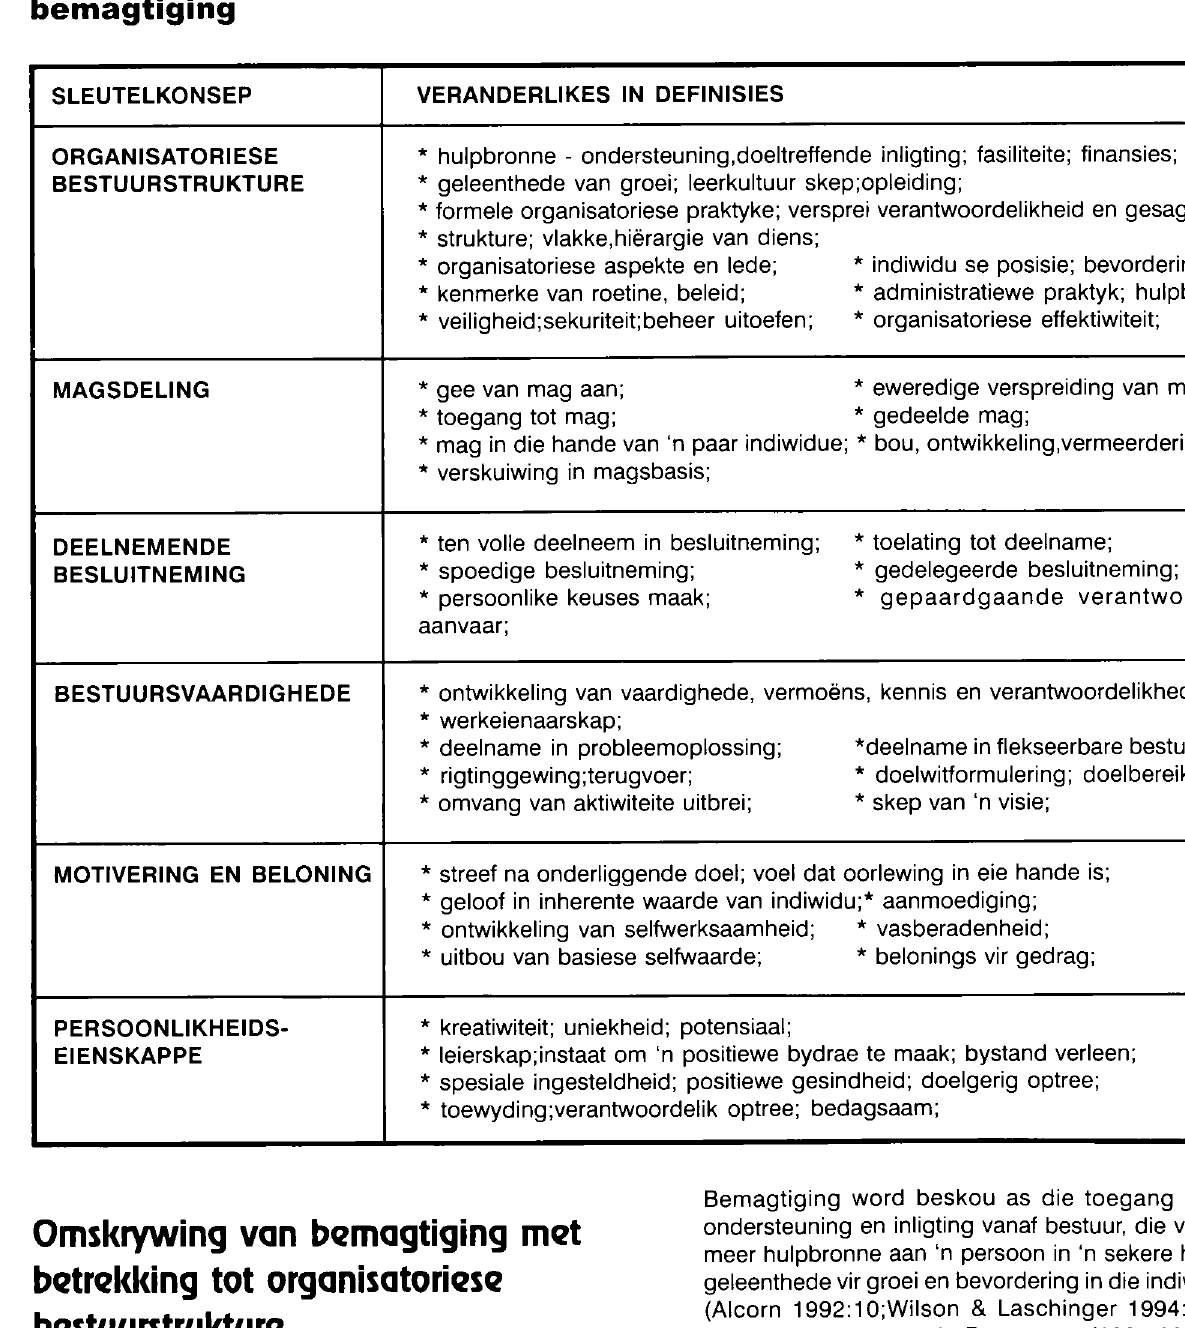
Tabel 1 Veranderlikes van die sleutelkonsepte in die definisies aangaande